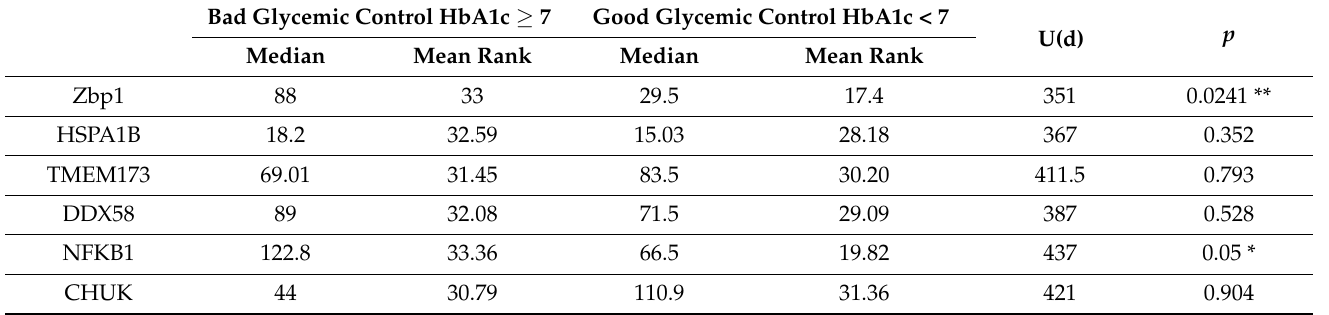
Table 2. Relation between the expression of the 6 mRNAs and the glycemic control in the T2DM group.